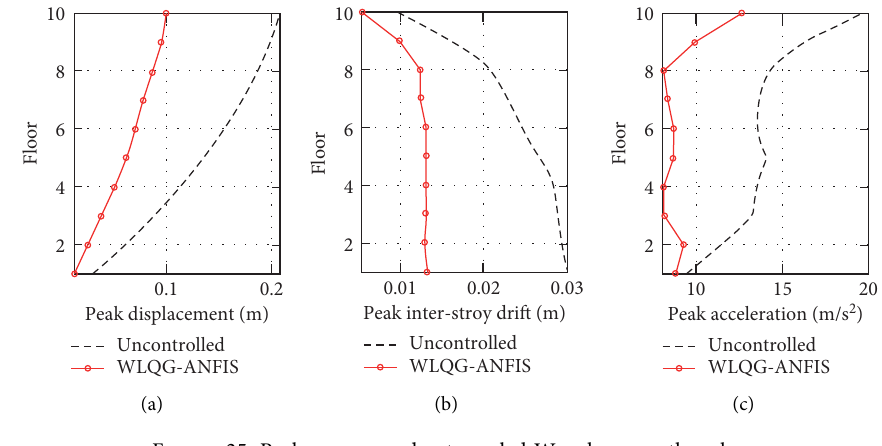
Figure 25: Peak responses due to scaled Wenchuan earthquake. Table 7: Maximum responses (reduction ratios) under varied seismic excitations with and without control. Earthquake excitation Control strategy